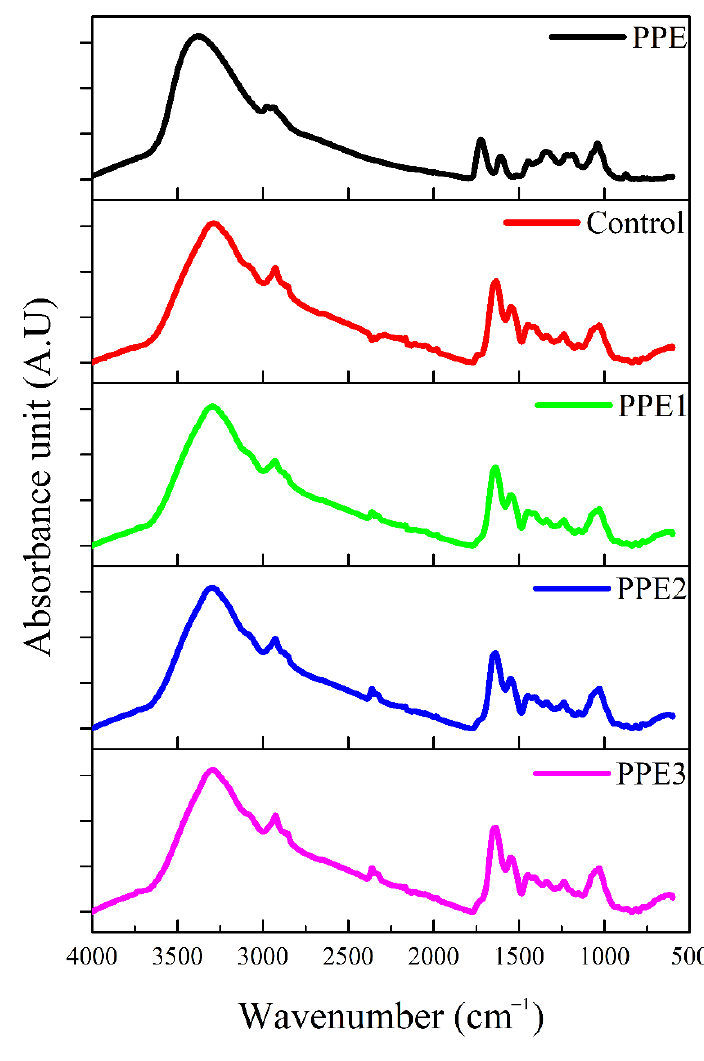
Figure 4. Effects of pomegranate peel extract (PPE) concentration on the Fourier transform infrared (FT-IR) spectrums. (PPE: pomegranate peel extract; C: Control without PPE; PPE1: “Boba balls” containing 1% PPE; PPE2: “Boba balls” containing 2% PPE; PPE3: “Boba balls” containing 3% PPE).